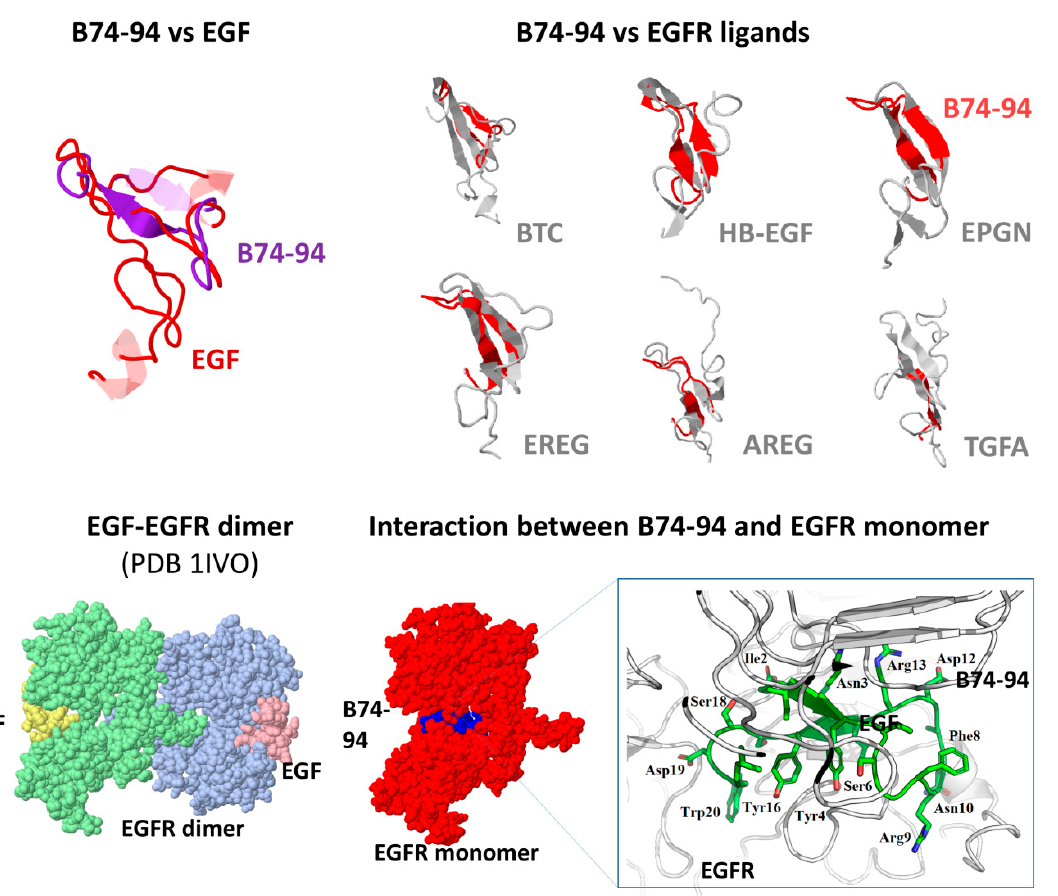
Figure 4. Molecular modeling of the interaction between the peptide B74–94 and EGFR. ( A ) Superposition of B74–94 peptide (purple) with EGF (red, PDB 2KV4) and other EGFR ligands. ( B ) The model of EGFR interaction with EGF (PDB 1IVO) and B74–94 peptide. The detailed view of EGFR and B74–94 interface is zoomed in.